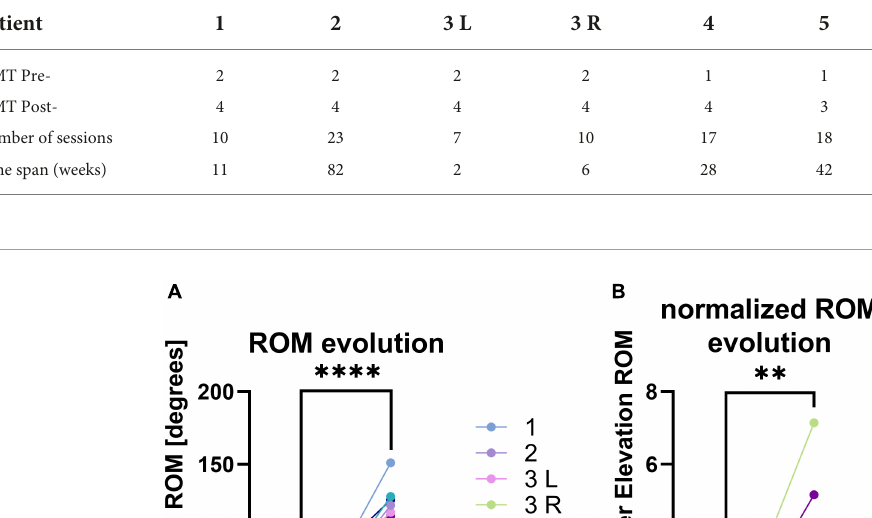
TABLE 2 MMT scores before and after and details of the HAL intervention.